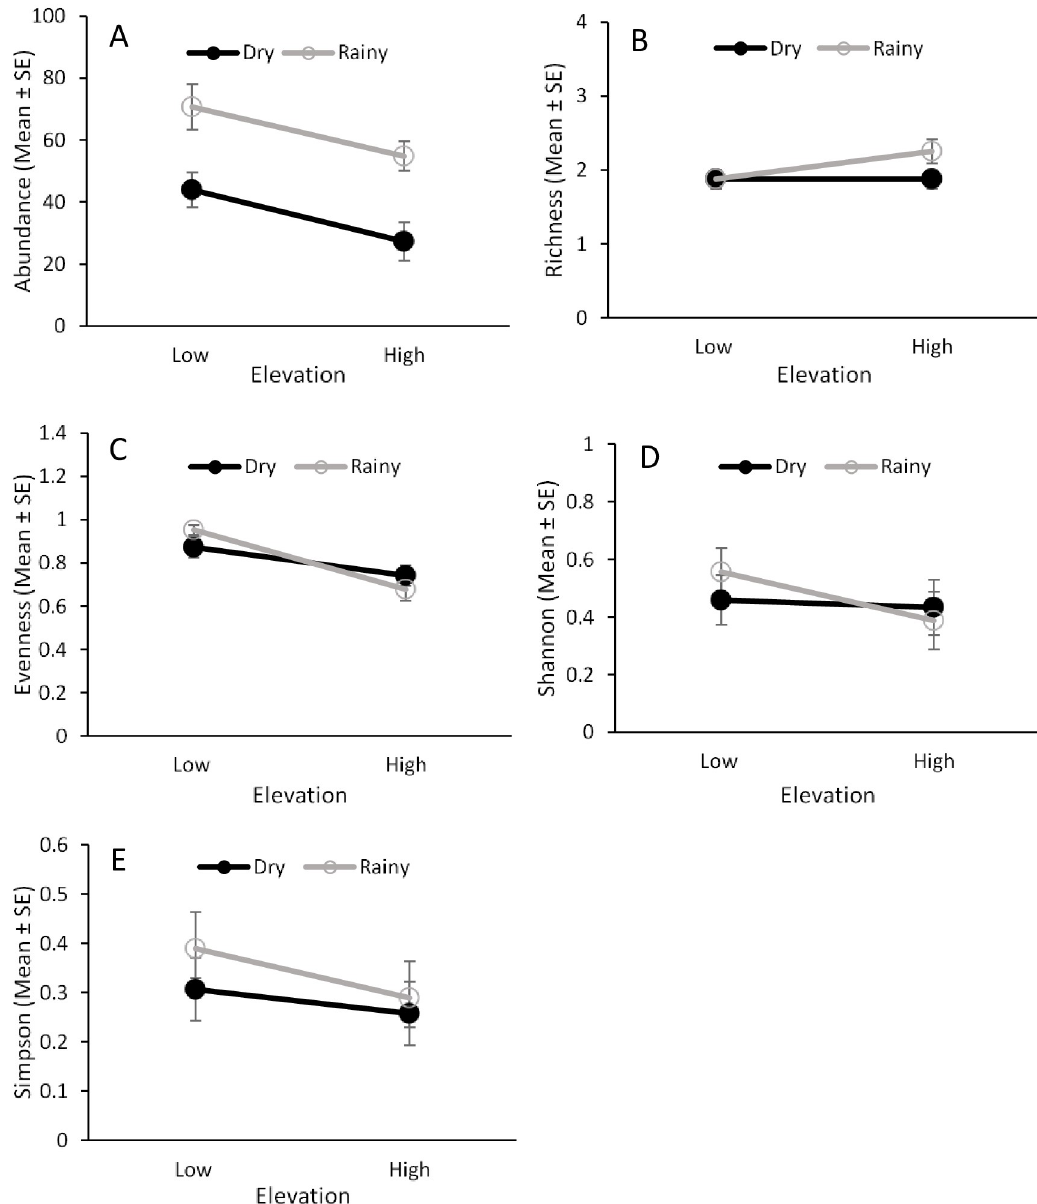
Fig 5. Fruit fly abundance and species diversity in fruit. Effects of elevation (low and high) and seasonality (dry and rainy) on the abundance (A), species richness (B), species evenness (C), and Shannon’s (D) and Simpson’s (E) indices for fruit flies that emerged from guava fruit from